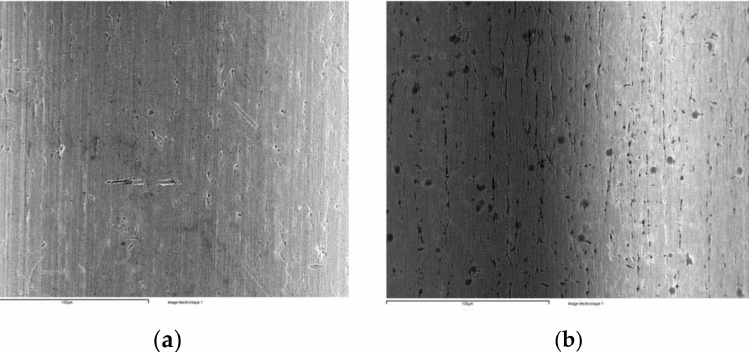
Figure 18. Images of hypotube #16: ( a ) before the intergranular test (scale = 100 µ m) and ( b ) after the intergranular test (scale = 100 µ m).